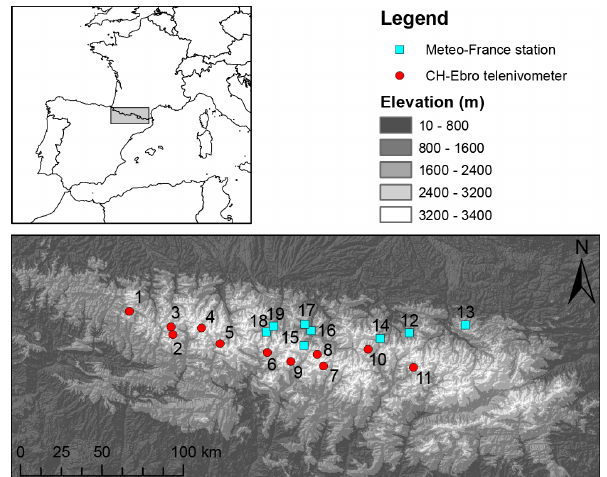
Figure 2. Hydraulic infrastructures in the Adour, Garonne and Ebro rivers